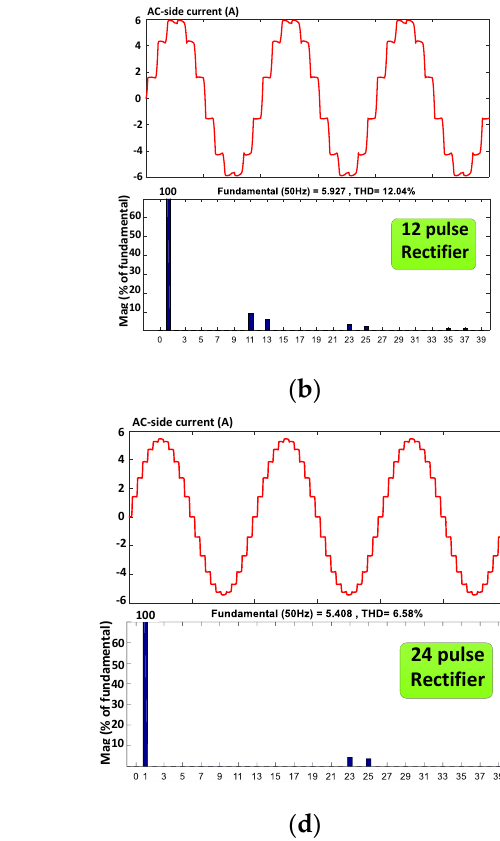
( b ) 12-pulse ( c ) 18-pulse ( d ) pulse ( c ) 18-pulse ( d ) 24-pulse.